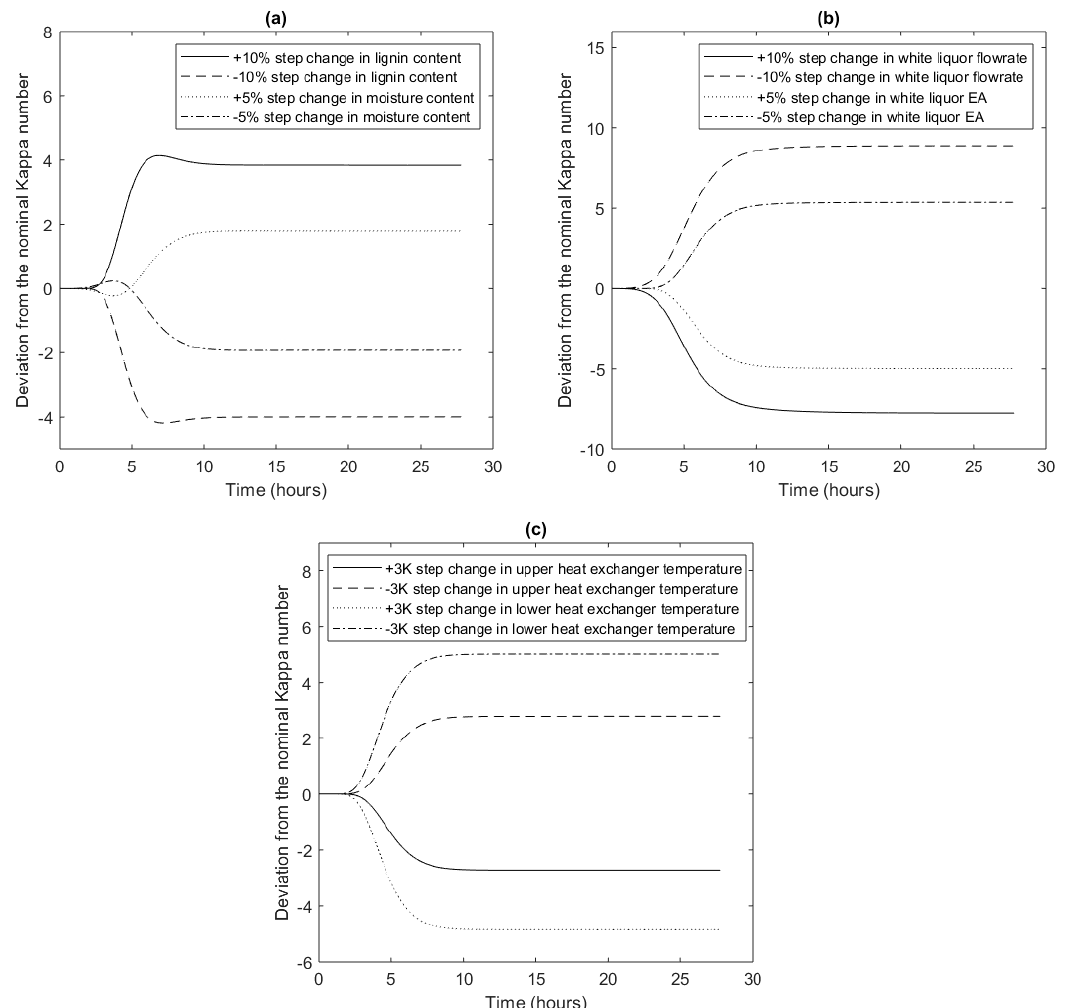
Figure 6. Step change in ( a ) wood chips lignin and moisture content, ( b ) free liquor flowrate and EA and ( c ) upper and lower recirculation heat exchanger temperature.